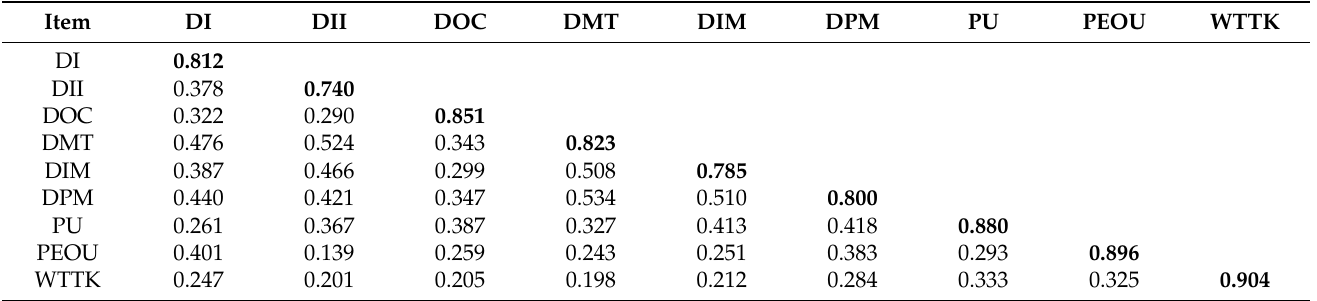
Table 4. Correlations among major constructs.